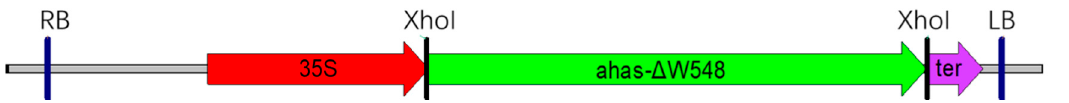
Figure 5. Diagram of T-DNA cassette for rice transformation. The ahas- Δ W548 gene replaced the hygromycin resistant gene and served as a selection marker. This gene was driven by a 35S promoter. RB and LB: right and left border of T-DNA; 35S: 35S promoter of the CaMV; ter: terminator of the CaMV.